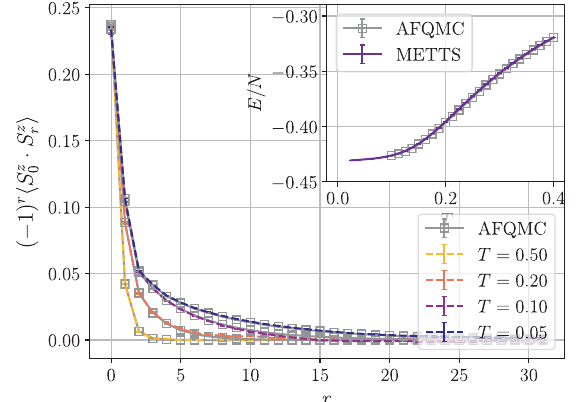
FIG. 13. Comparison of spin-correlation functions h S z 0 · S z r i along one leg of a 32 × 4 cylinder at half filling and internal energy density E=N between METTS and AFQMC. We use a cutoff of ε ¼ 10 − 6 and a maximum bond dimension D 2000 for imaginary-time evolution in METTS. Both quantities agree within error bars. A comparison of the specific heat is shown in Fig. 6(a).